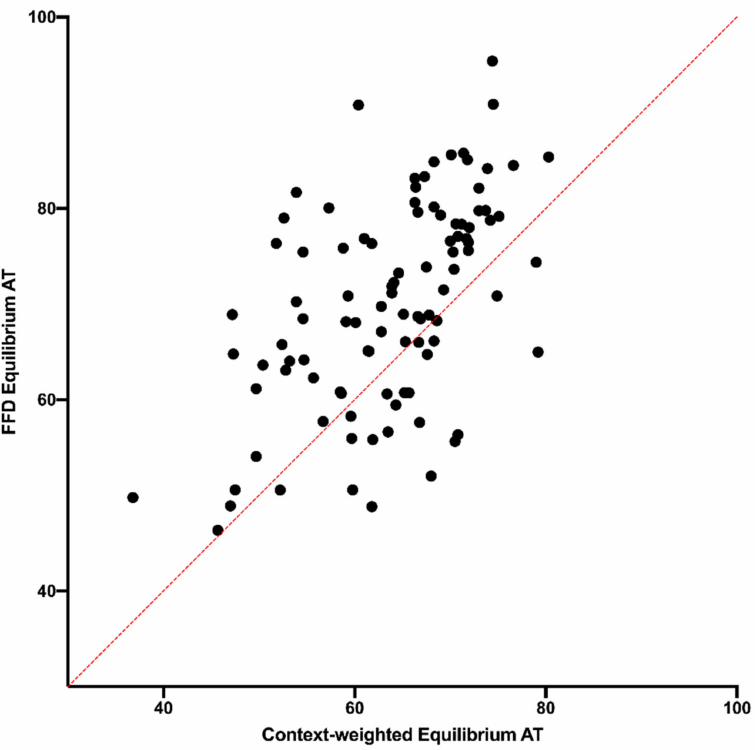
Figure 6. A comparison of predicted equilibrium A+T content at FFD sites and the AT w values, which are weighted by context distribution as described in the text.